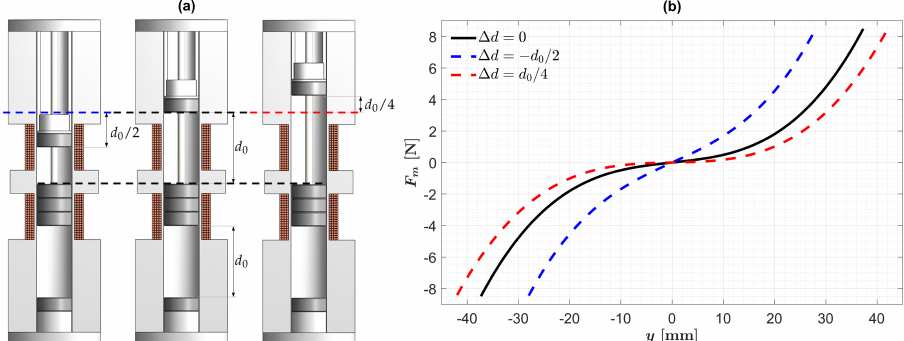
Figure 2. ( a ) Variation in the harvester length from − d 0 /2 (cid:54) ∆ d (cid:54) d 0 /4 (windings were not considered to simplify this illustration); ( b ) force–displacement curves when the harvester variation length is: neglected ( ∆ d = 0, black solid line); shortened to ∆ d = − d 0 /2 (blue dashed line); and extended to ∆ d = d 0 /4 (red dashed line).